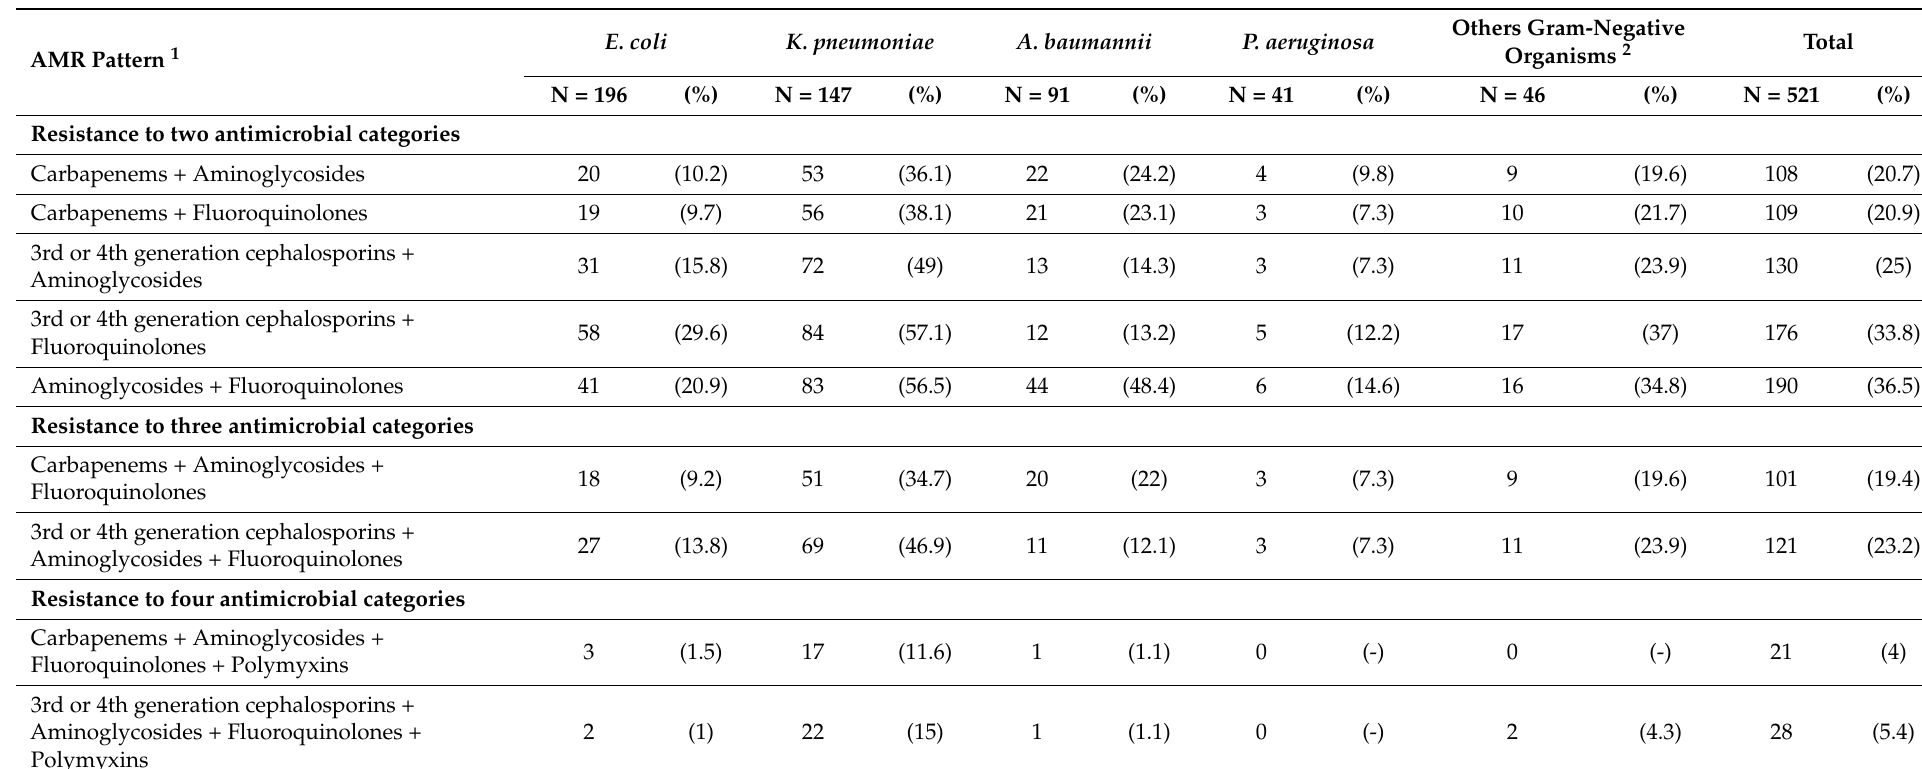
Table 4. Distribution of the AMR combination among Gram-negative organisms by bacterial species and tested antimicrobial categories. E. AMR Pattern 1